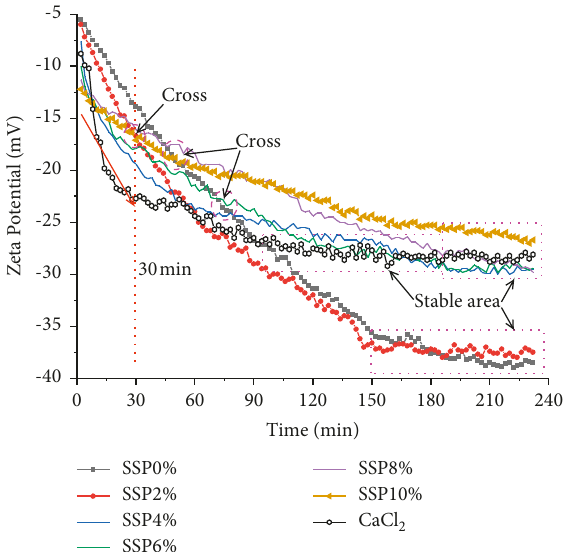
Figure 10: Zeta potential change